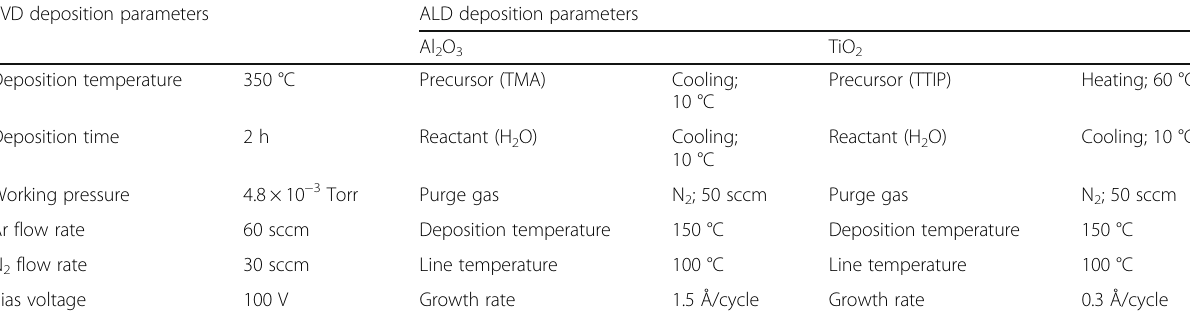
Table 1 The deposition parameters of the PVD and ALD processes PVD deposition parameters